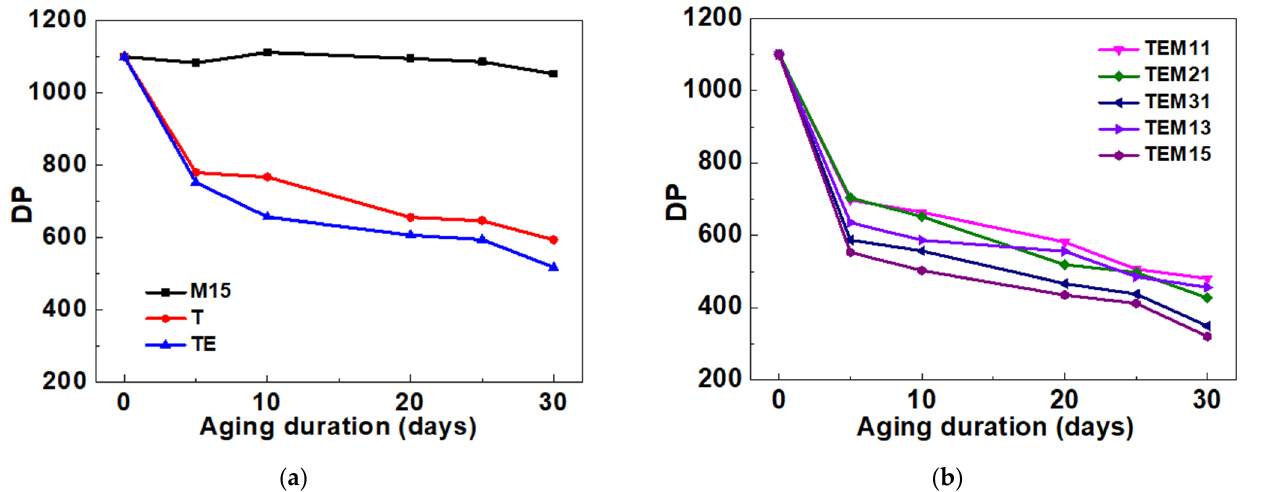
Figure 17. DP of the pressboard of ( a ) control groups and ( b ) experimental groups. Table 7. Kinetics of cellulose degradation parameters in OIP under simultaneous multi-stress aging [19].